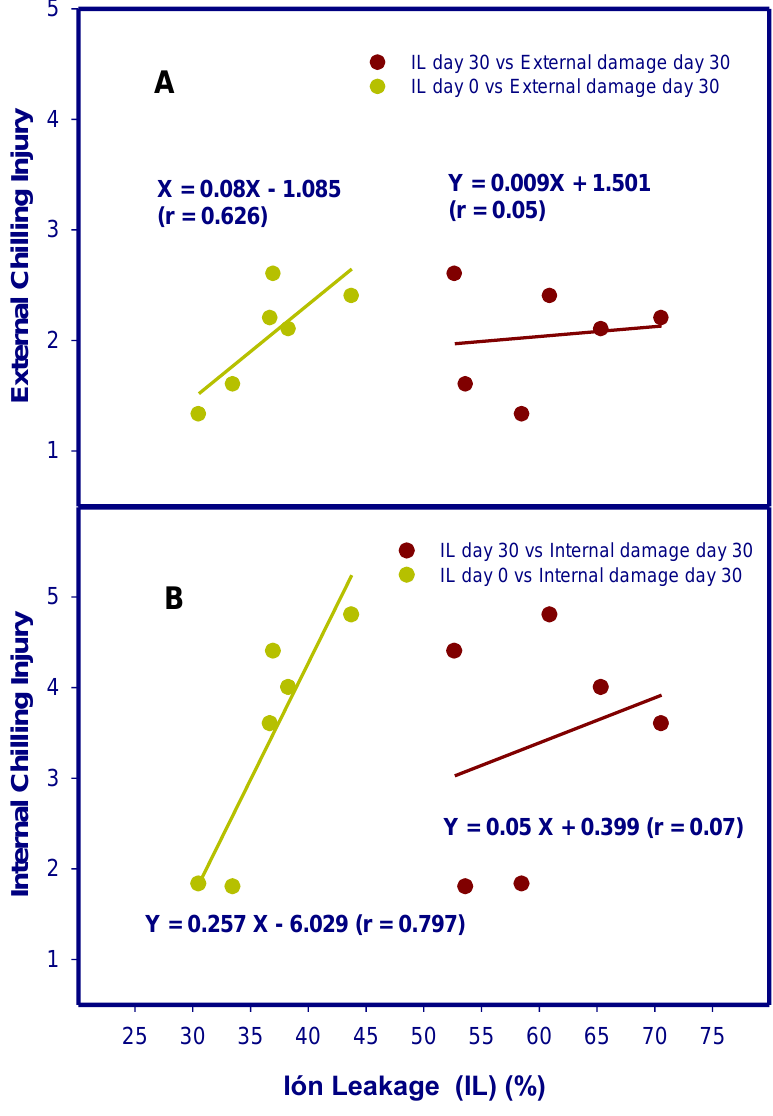
Figure 3. Correlation between external ( A ) and internal ( B ) chilling injury in pomegranate peels of different cultivars and ion leakage at harvest (green circle) and after storage for 30 d at 2 °C plus 2 d at 20 °C (red circle).